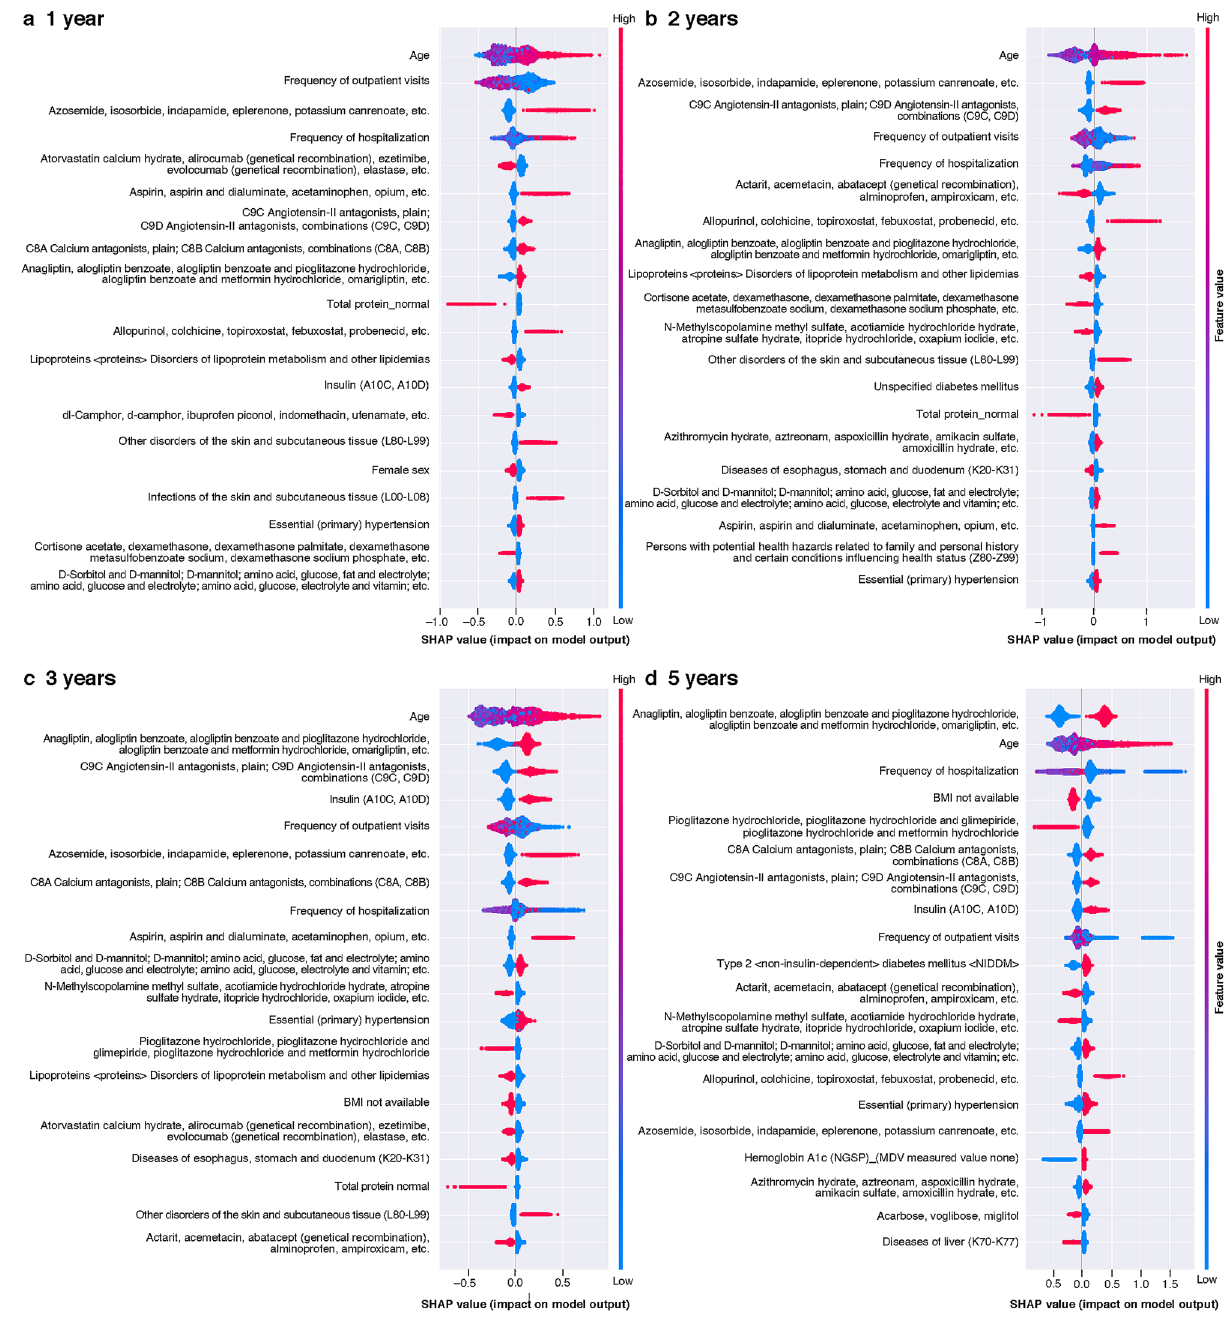
Figure 5. SHAP summary plot in XGB model with 60 variables and 16 laboratory values. ( a )–( d ) Hospitalizations for CKD/HF. BMI body mass index, CKD chronic kidney disease, HF heart failure, NGSP National Glycohemoglobin Standardization Program, SHAP SHapley Additive